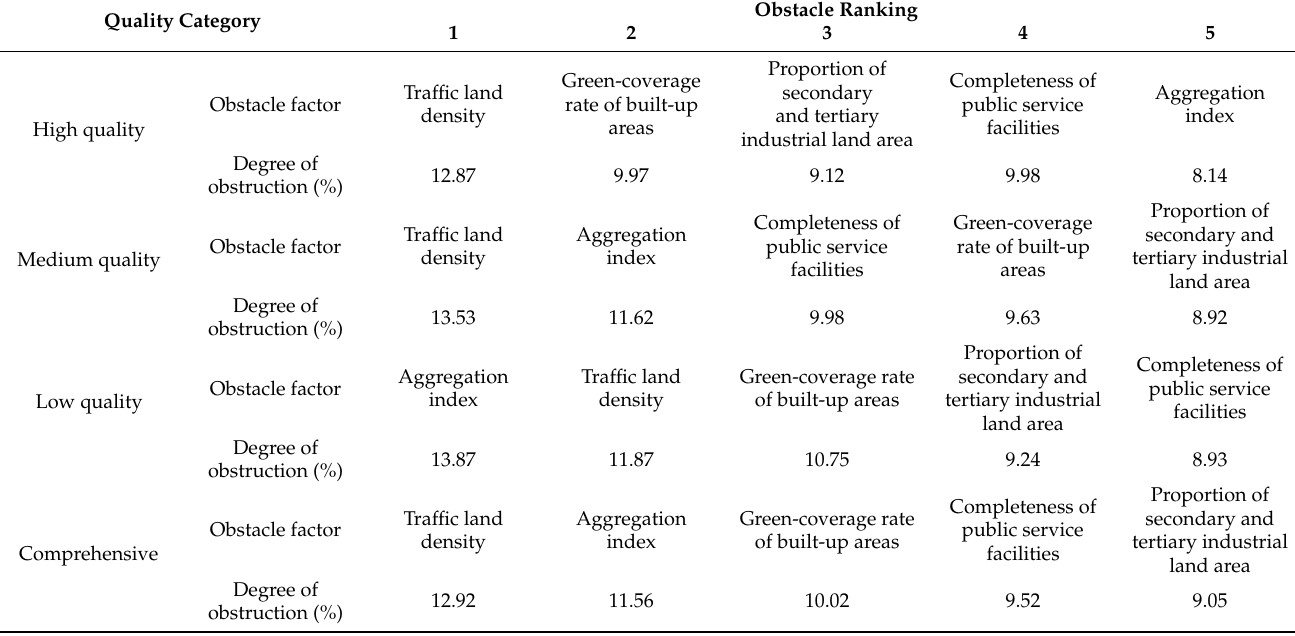
Table 3. Main obstacle factors of rural residential area utilization